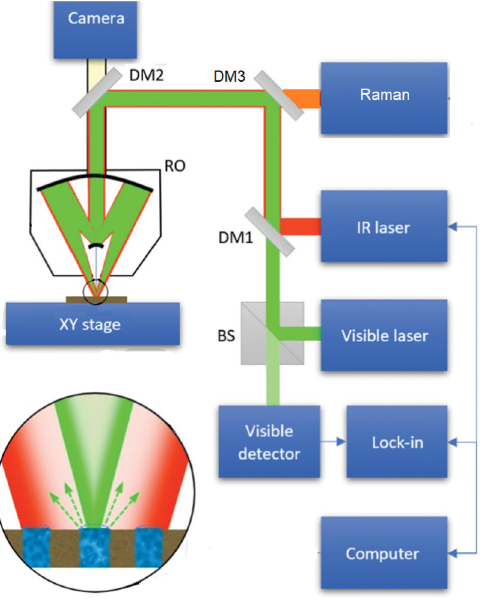
Figure 7. Schematic diagram of O-PTIR spectroscopy. A pulsed tunable IR laser is collinear with the visible detection laser, and the beams are focused via dichroic mirrors (DM1-3) on the sample surface through a reflective objective (RO). When IR absorption occurs, the photothermal response of the sample surface is monitored by the visible probe laser. The reflected light passes through a beam splitter (BS), is measured by a visible detector, and the IR signal is extracted while sweeping the wavelength of the IR laser source. Raman- shifted light is simultaneously diverted to the Raman